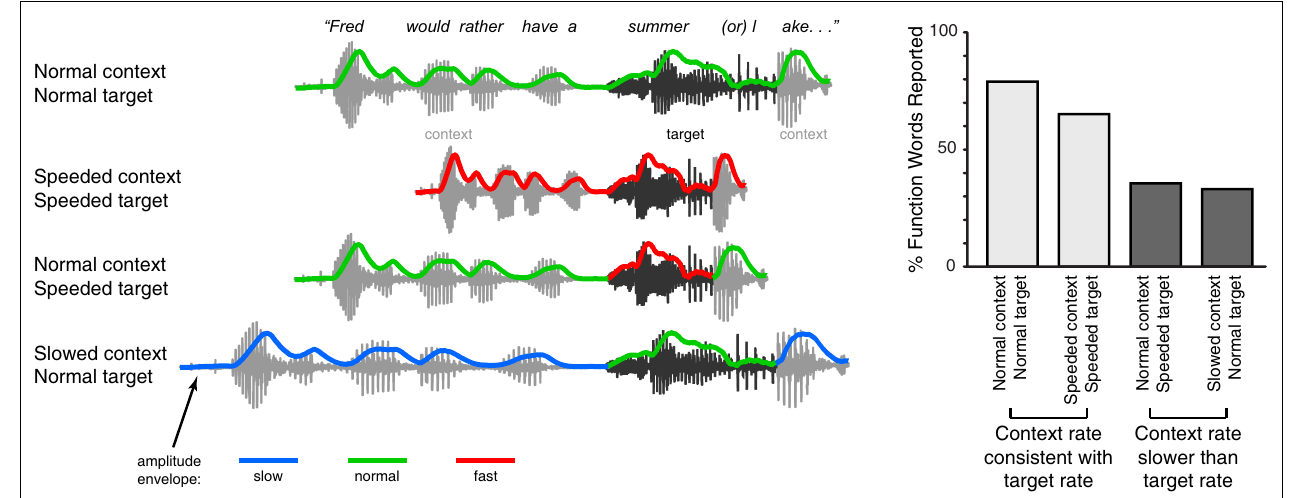
example, “or”) was measured.These conditions are shown along the left side of the figure, along with the acoustic amplitude envelope for each stimulus (colored lines).The authors found that when the speech rate of the context and target word matched, word report for the function word was relatively high; by contrast, when the context was slower than the target word, fewer function words were reported.This result shows how listeners make use of contextual speech rate to guide lexical segmentation during speech